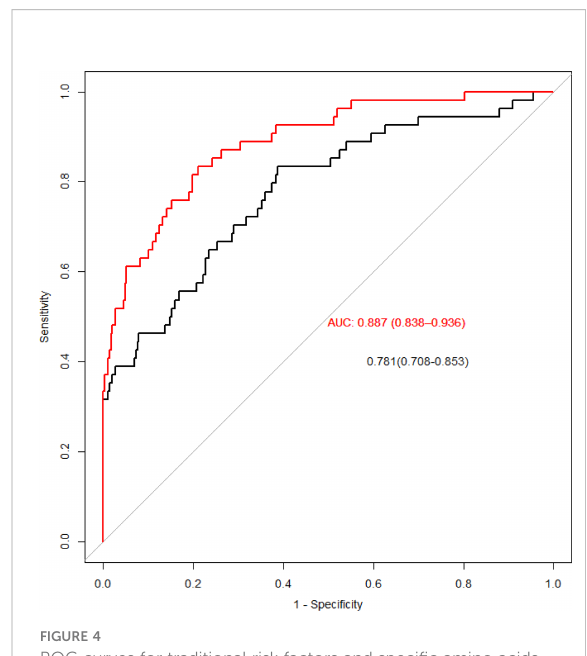
FIGURE 4 ROC curves for traditional risk factors and speci fi c amino acids added. The red line is obtained by adding metabolites, and the black line is obtained by only traditional risk